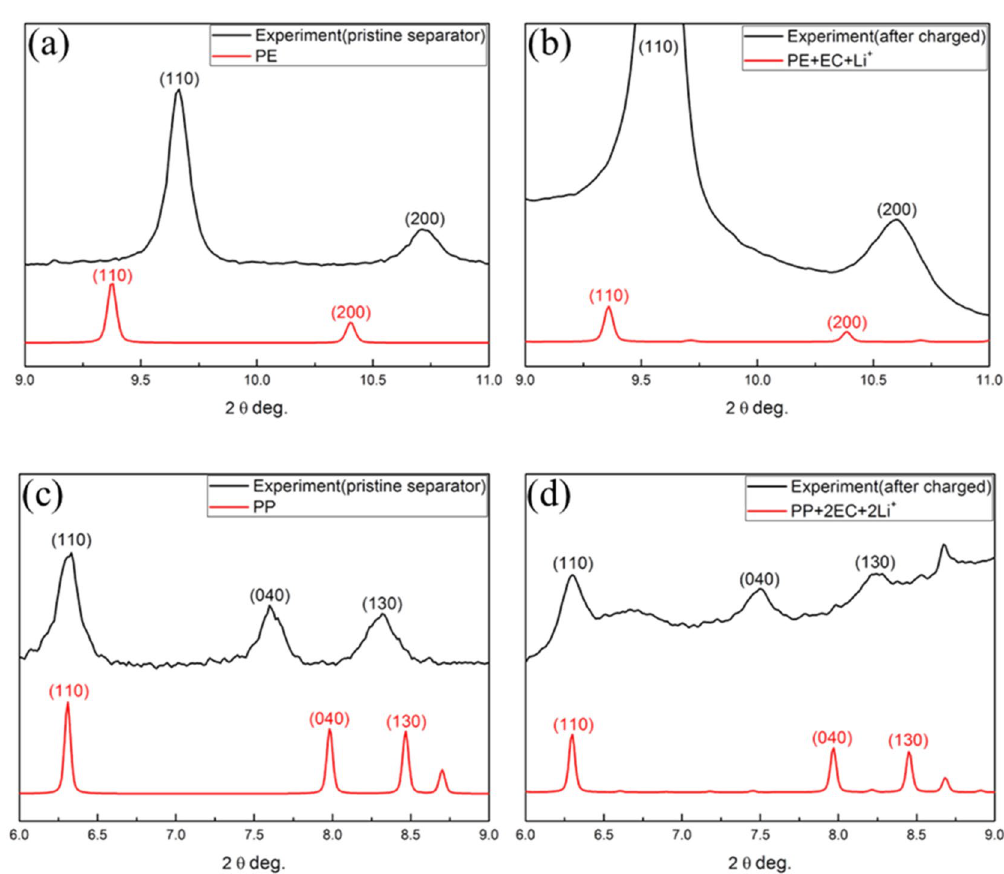
Figure 7. Comparison of simulated XRD pattern of ( a ) pure PE, ( b ) PE-EC-Li + model, ( c ) pure PP and ( d ) PP-2EC-2Li +